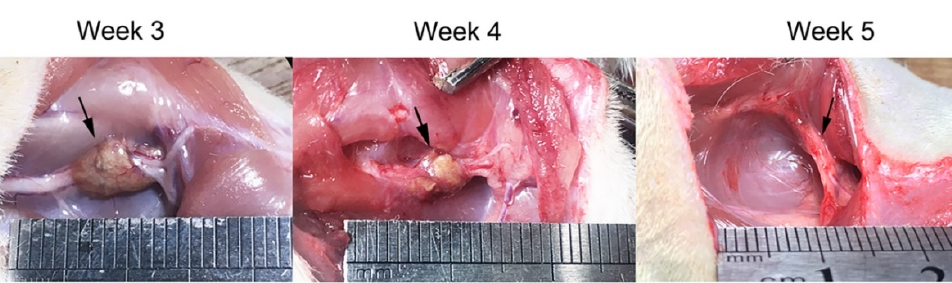
Figure 4. Sciatic nerve injury repair using keratin sponge. ( a ) Scanning electron microscope showing the micro-porous structure of keratin sponge. ( b ) Schematic illustration of the sciatic nerve crush injury model. ( c ) Keratin sponge degradation. Reprinted with permission from Gao, J.; Zhang, L.; Wei, Y.; Chen, T.; Ji, X.; Ye, K.; Yu, J.; Tang, B.; Sun, X.; Hu, J. (2019). Copyright 2019 Journal of Materials Science: Materials in Medicine, Springer Nature [109].